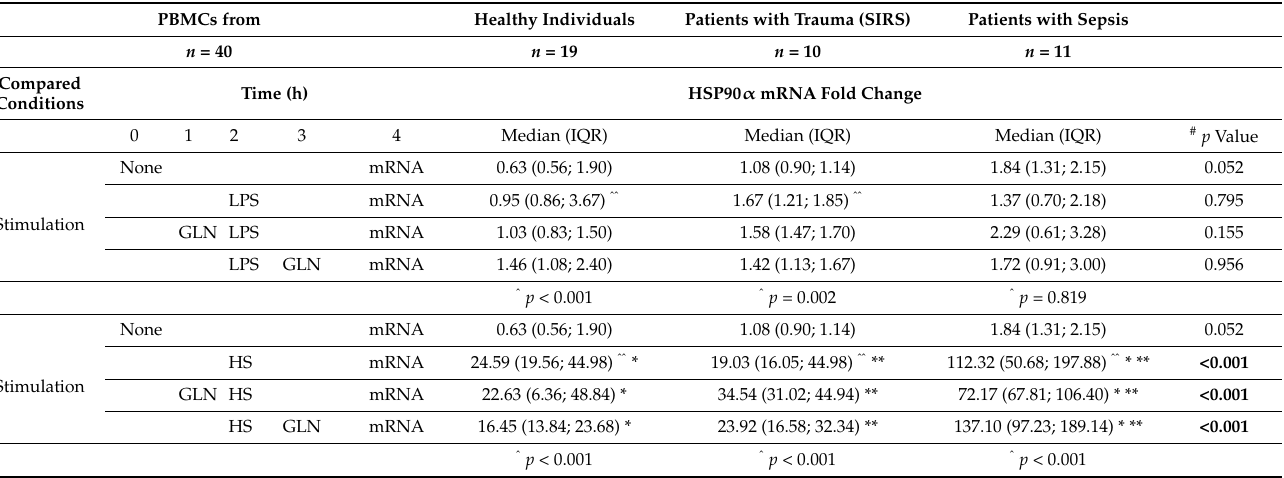
Table 2. Comparison analysis of relative HSP90 α gene expression among different stimulation conditions of peripheral blood mononuclear cells without or with glutamine pre- or post-treatment in patients with sepsis or trauma and healthy